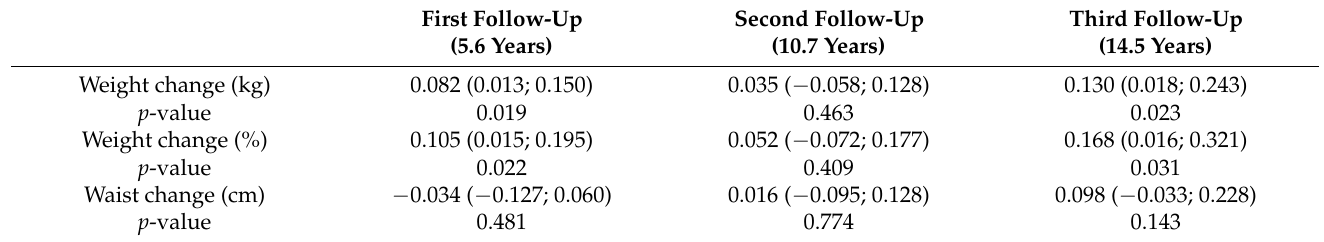
Table 2. Mendelian randomization results of the association between 25-hydroxyvitamin D levels and 5-, 10-, and 15-year changes in weight, CoLaus study, Lausanne,